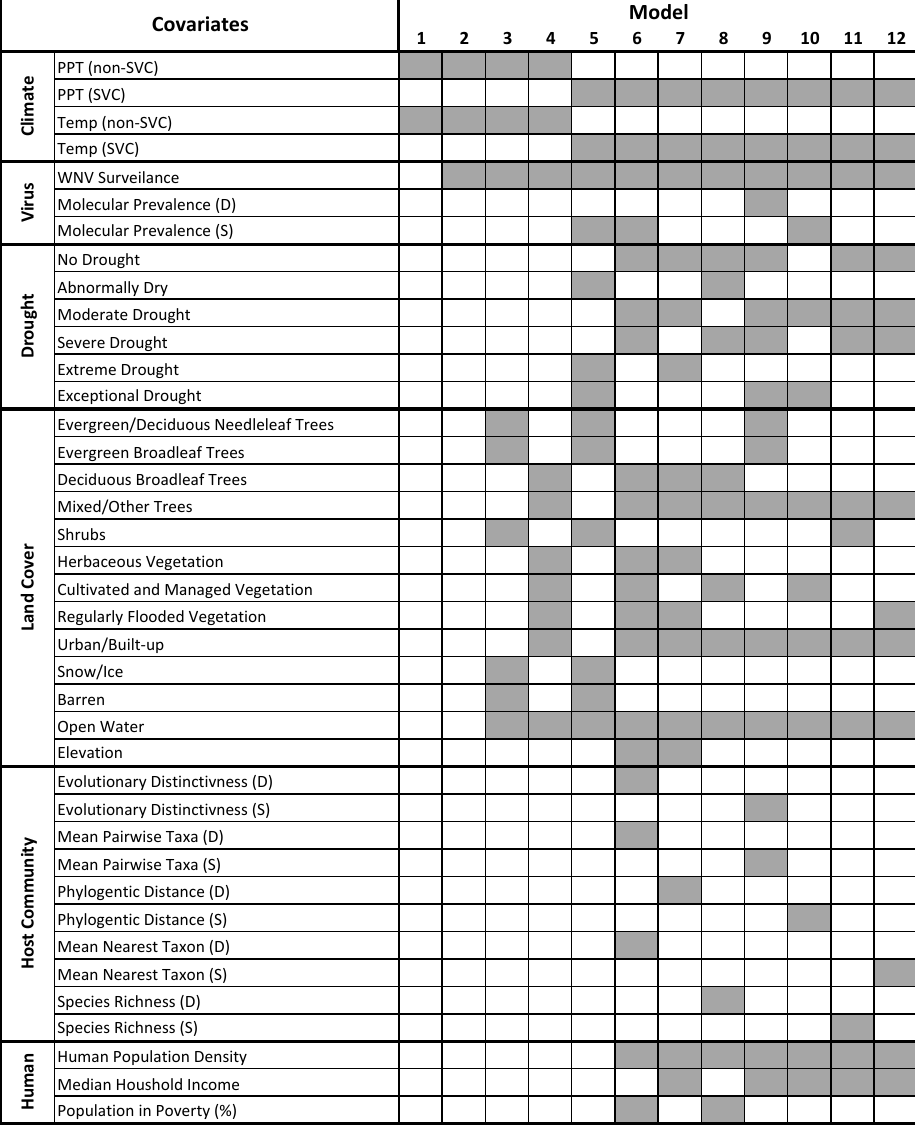
Figure A1. Evaluated model covariates. Covariates are listed by category in the first column. Columns following covariate name correspond to twelve models constructed to evaluate covariates (numbered 1–12) and are shaded by row to indicate covariate inclusion. The abbreviation SVC when listed with a covariate name indicates implementation as a Spatially Varying Coefficient, parenthetical listing of (D) signifies the covariate was added under assumption of a dynamic species pool (monthly varying), and parenthetical (S) indicates use of a static pool (seasonal, months May–August). Models 5–12 included climate SVC covariates and were subjected to model averaging to derive mean consensus estimates of WND